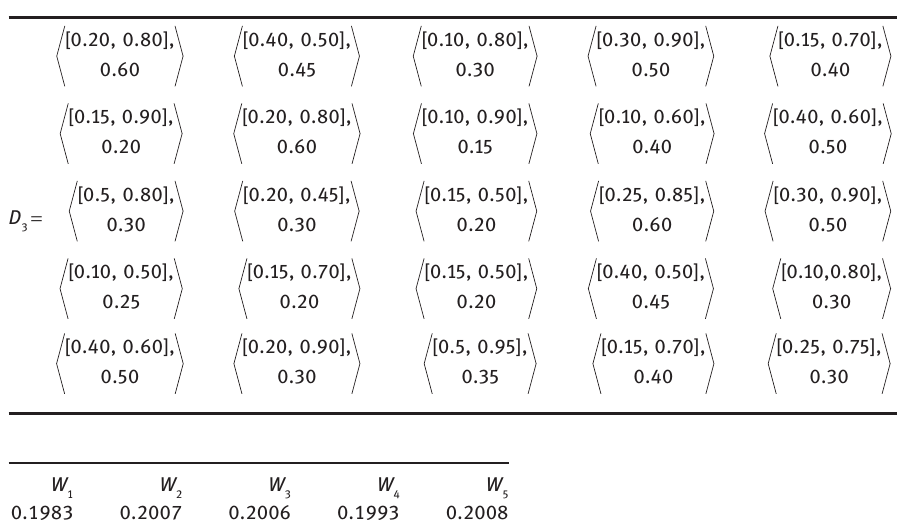
Table 9: Decision Matrix